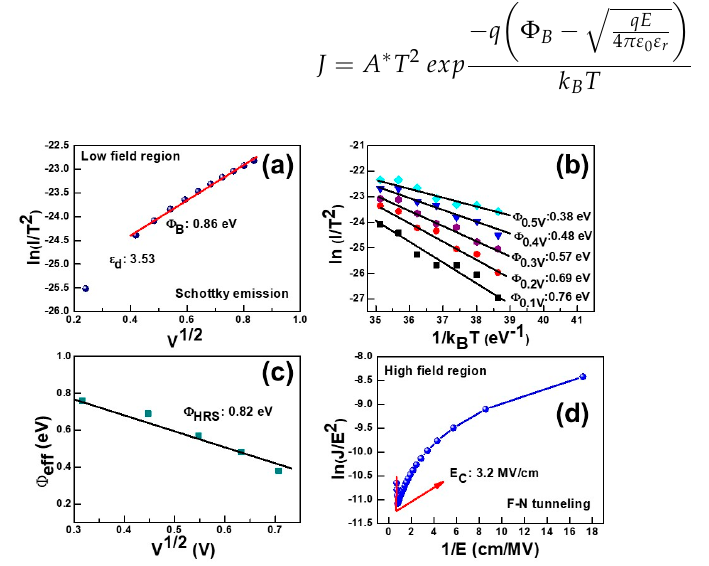
Figure 6. Charge transportation mechanism exploration by I–V curve fitting at room temperature.